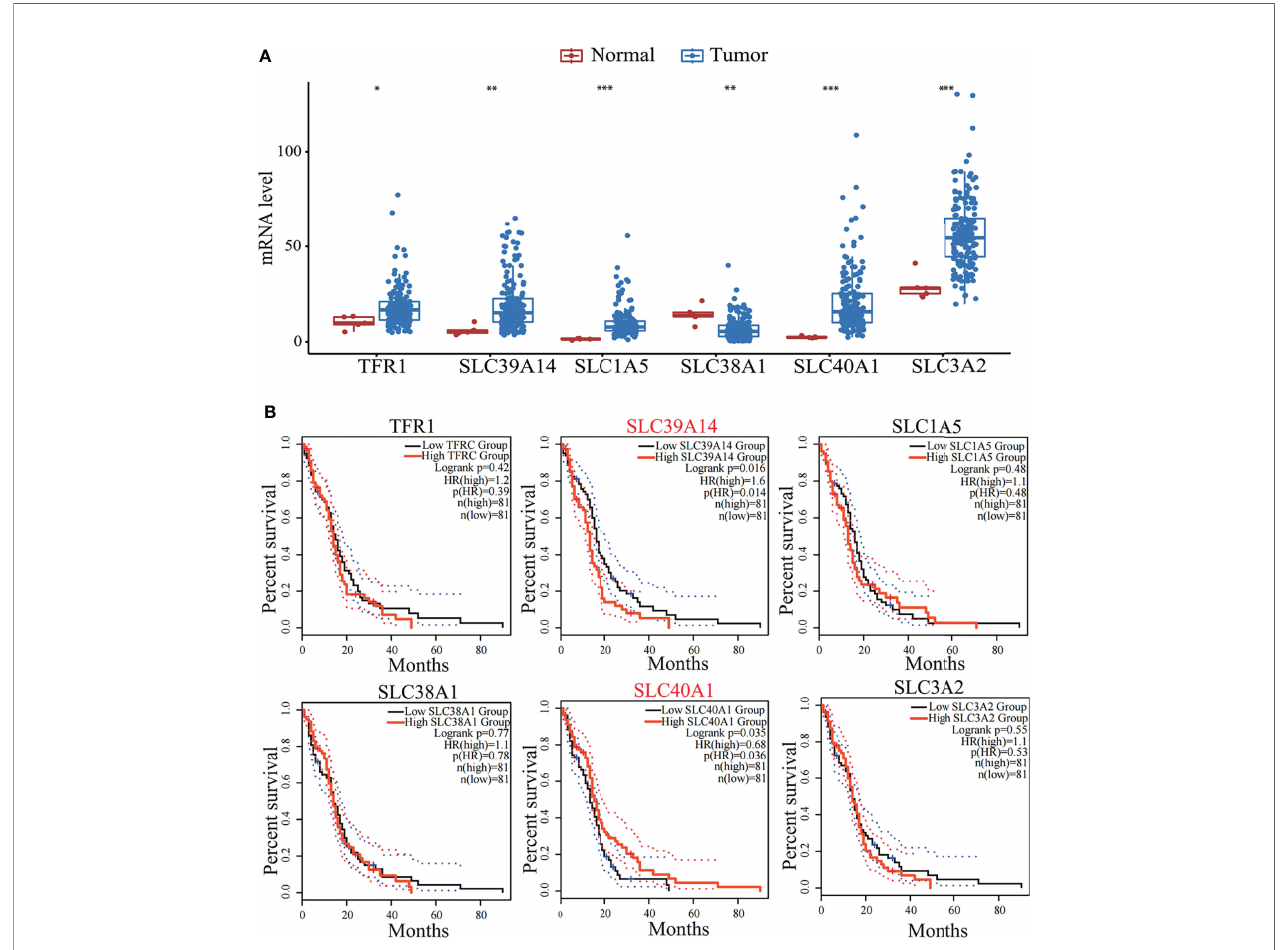
FIGURE 2 | (A) Expression level of transporters (TFR1, SLC39A14, SLC1A5, SLC38A1, SLC40A1, SLC3A2) in tumor patients and normal people. Data mined from TCGA (https://cancergenome.nih.gov/). *p < 0.05, **p < 0.01, ***p < 0.001, compared with tumor patient group. (B) Survival curves of GBM patients mined from GEPIA2 (http://gepia2.cancer-pku.cn/). GBM patients were strati fi ed into high or low expression groups based on the expression level of transporters (TFR1, SLC39A14, SLC1A5, SLC38A1, SLC40A1, SLC3A2) of patients. p<0.05 in Log ‐ rank test. OS, overall survival in